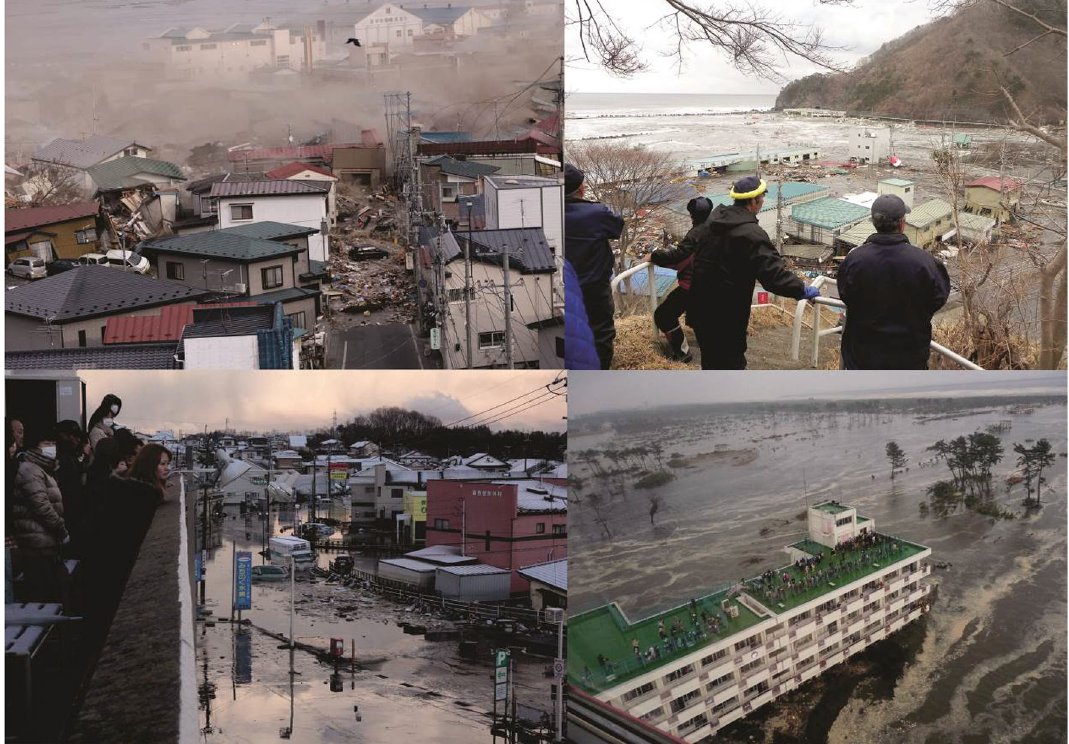
Fig. 2 Impacts of the 2011 Great East Japan Earthquake and Tsunami. Top left: Yamada Town, Iwate Prefecture. Top right: Fudai Village, Iwate Prefecture. Bottom left: Tagayo City, Miyagi